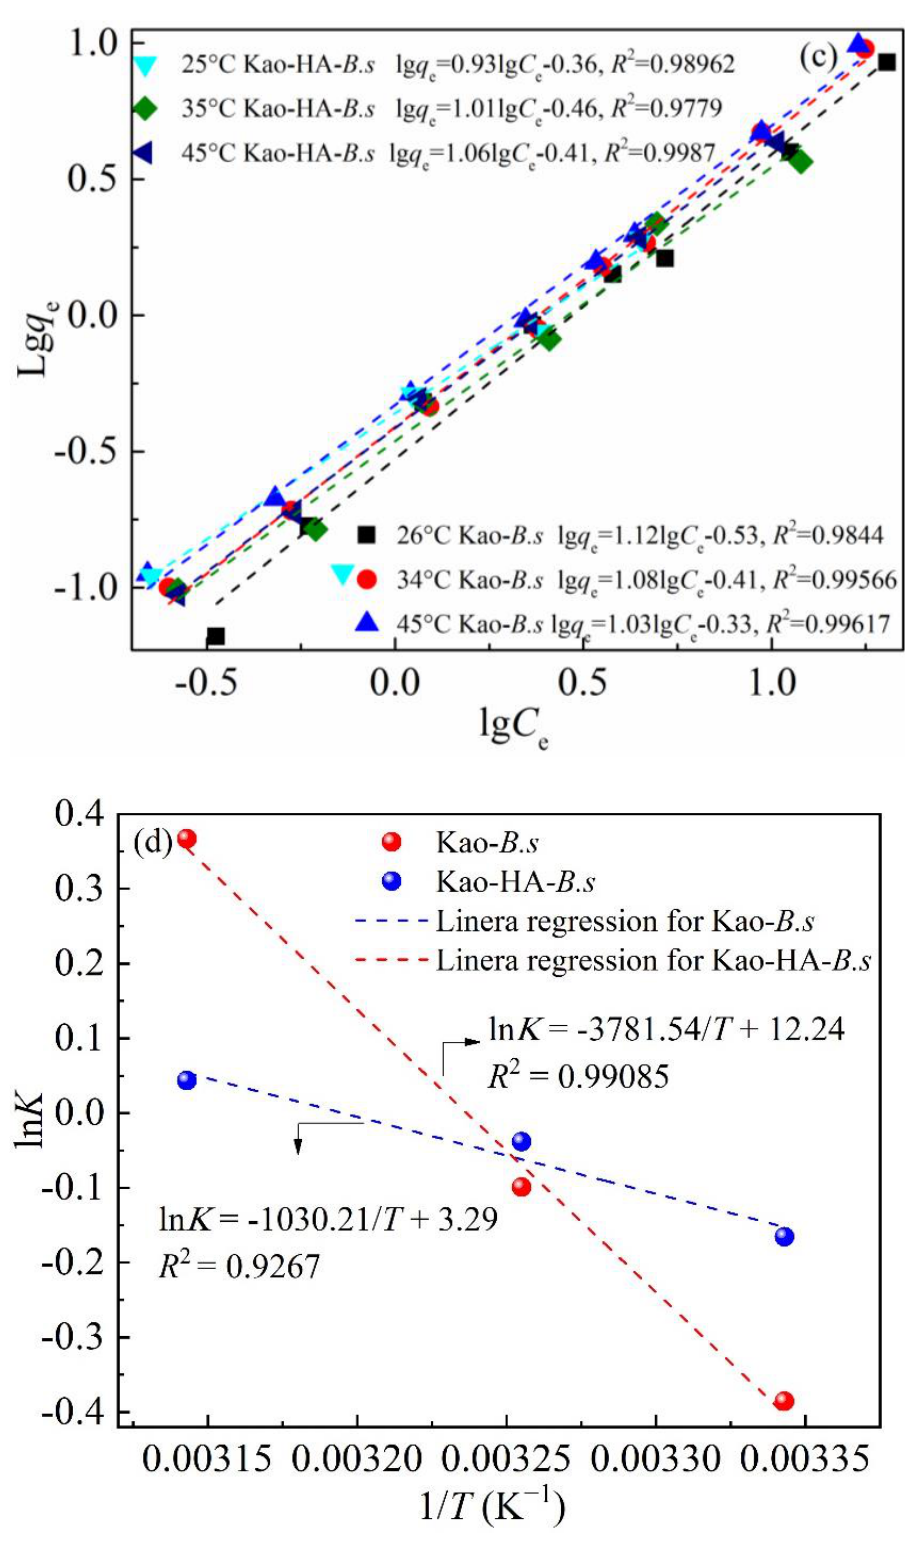
Figure 6. As(V) adsorption isotherms on Kao- B.s ( a ) and Kao-HA- B.s (50:1:50) ( b ), Freundlich model fitting ( c ) and plot of ln k versus 1/ T ( d ) (Adsorbent dosage: 2.5 mg · g − 1 ; pH: 5; ionic strength: 0.01 mol · L − 1 ; t: 48 h). Table 2. Parameters for As(V) adsorption on Kao- B.s and Kao-HA- B.s systems by Freundlich iso- therm models.